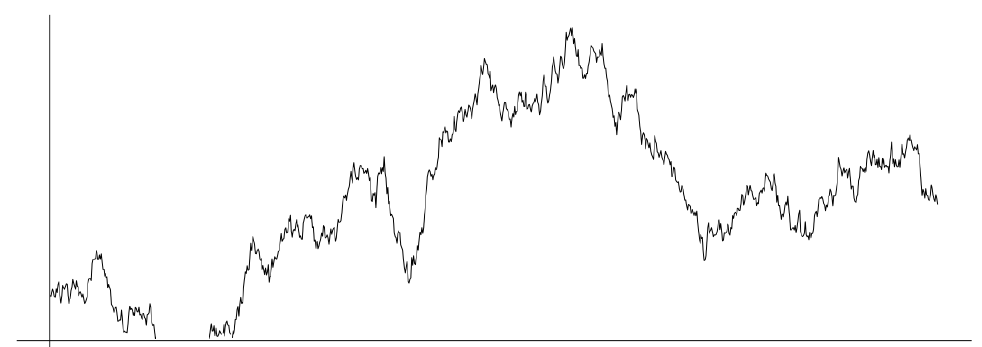
Figure 7. The 1-dimensional path (a realization of ˆ X or ¯ X ) exhibits a trap effect at zero. The process stops for a random amount of time (according with ¯ V − 1 ); then, it reflects continuously. The same effect can be considered on the boundary ∂ Ω for d -dimensional motions with random time-change ¯ V − 1